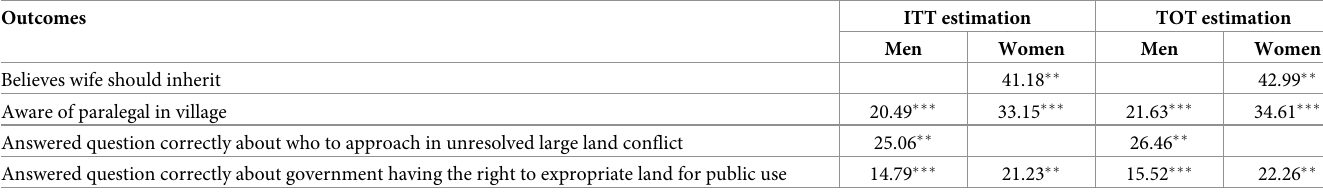
Table 12. CGLAS: Results of cost-effectiveness analysis, treatment based on assignment and